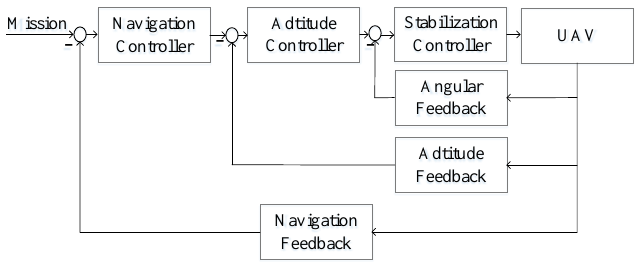
Figure 3. The flight control system for a single UAV.